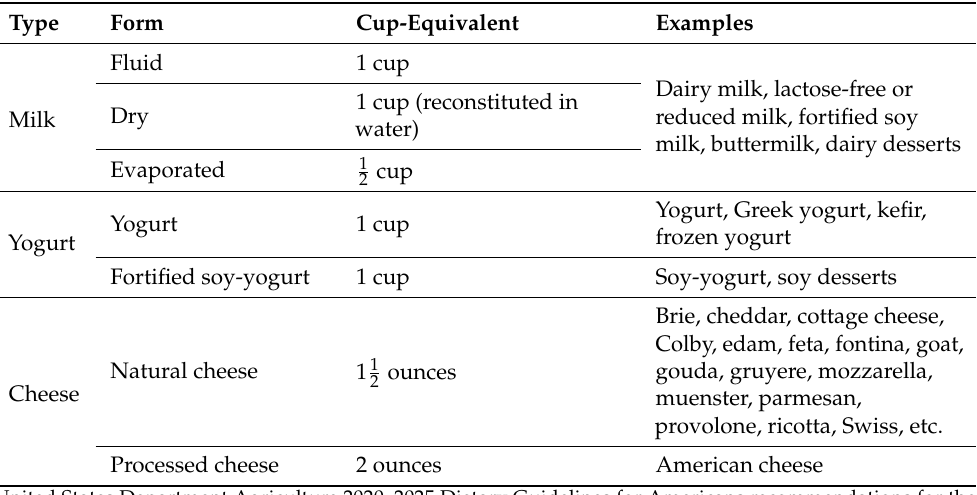
Table 7. MyPlate’s Dairy Group with Types, Examples, and Recommended